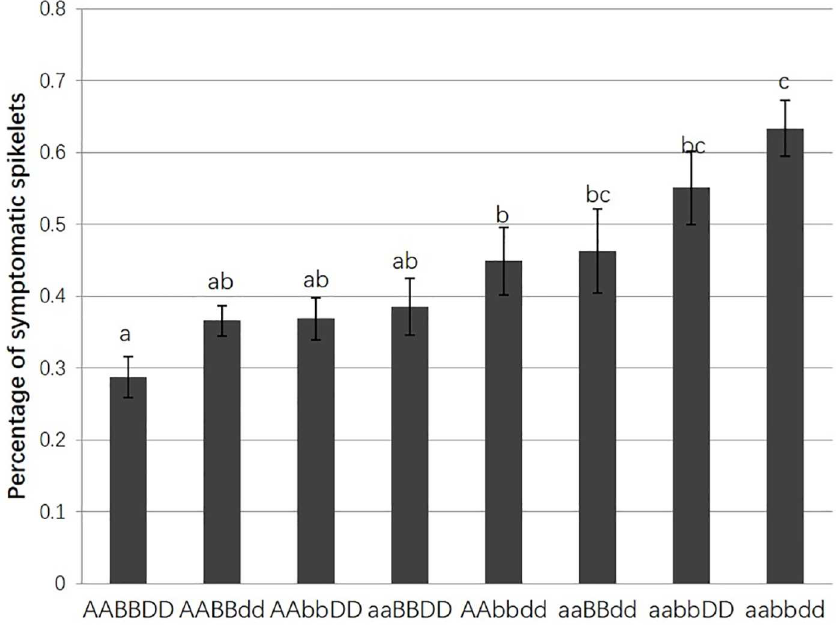
Fig 5. Effects of different combinations of three QTLs on 5A, 6B and 7D for percentage of symptomatic spikelets in a spike (PSS) analyzed in the RIL population. HYZ alleleswere assignedas AA (5A), BB (6B) and DD (7D) and ‘Wheaton’ allelesaa (5A), bb (6B) and dd (7D). The solid bars stand for mean PSS of each group, the length of each line refers to standard errors, and different letters indicated significant difference between two